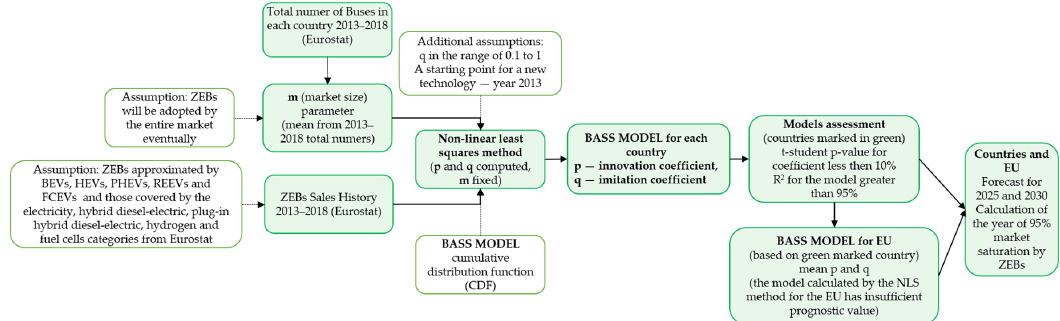
Figure 1. Subsequent stages of the proceedings [own study]. ZEB, zero-emission bus; NLS, nonlinear least square; BEV, battery electric vehicle; HEV, hybrid electric vehicle; PHEV, plug-in HEV; REEV, range-extended EV; FCEV, fuel cell EV.